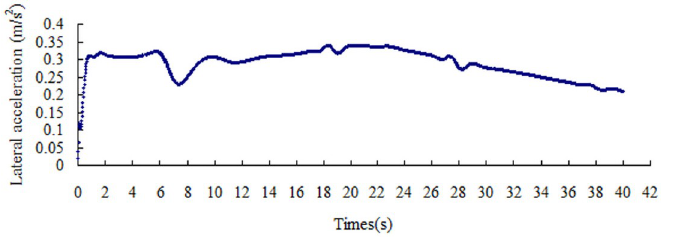
Fig 10. Lateral acceleration change graph of friction coefficient